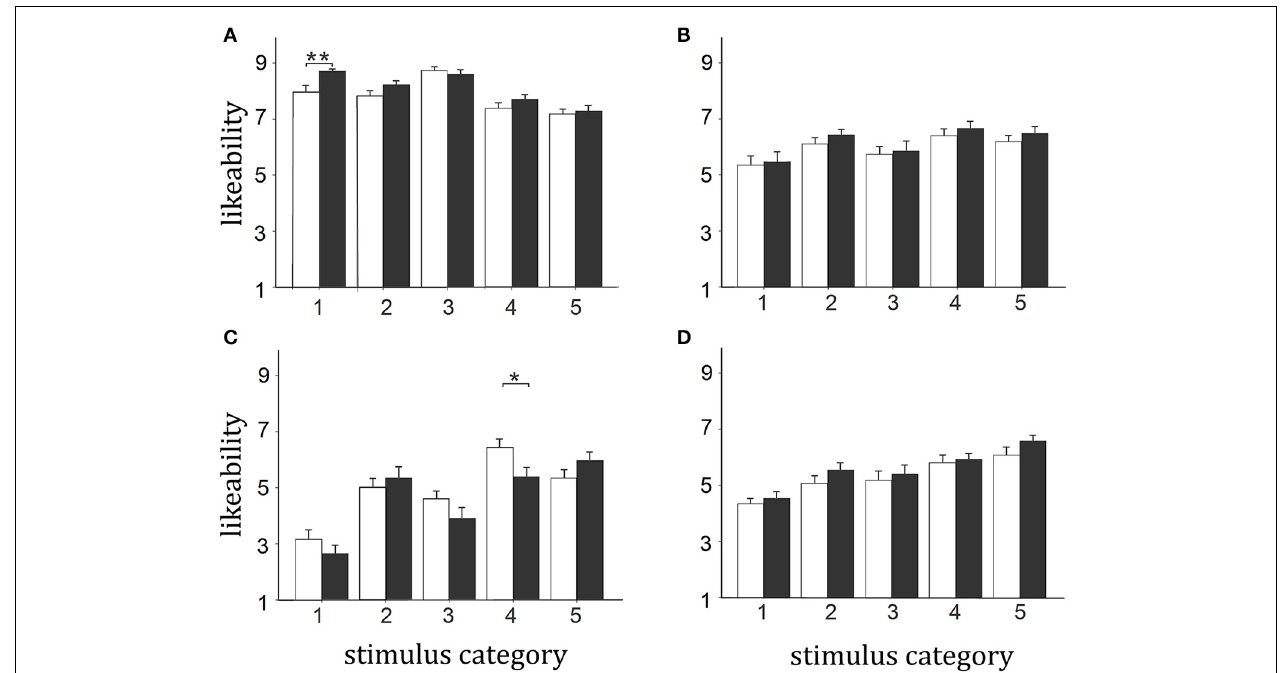
FIGURE 3 | Likeability ratings of different non-social stimulus categories for: (A) Chinese, (B) Taiwanese, (C) Japanese, and (D) South Korean. Histograms show overall mean ± s.e.m. combined likeability ratings for the different stimulus picture categories given by OXT and PLC treated subjects in the tests given 45min (test 1) and 7 days (test 2) after treatment. Non-social categories—1. Chinese flag – Flag and Flag-map; 2. Ancient and modern